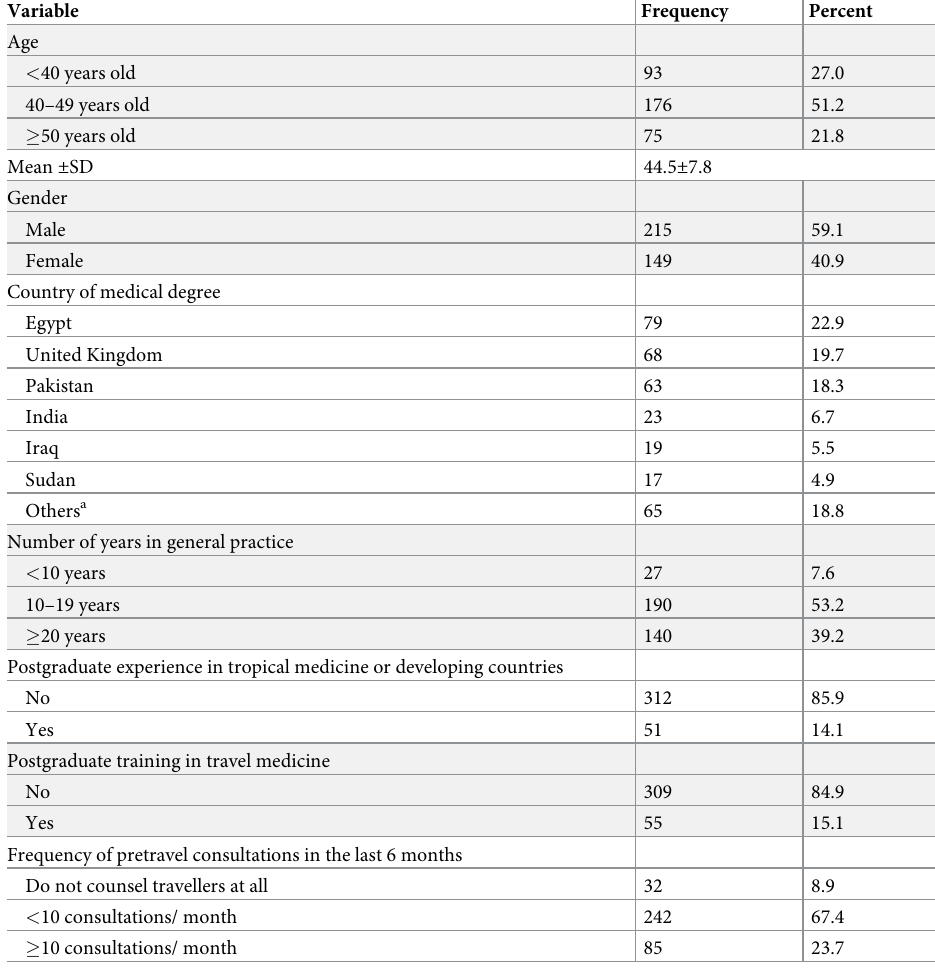
Table 1. Distribution of background characteristics of primary care physicians in Qatar (N = 364).